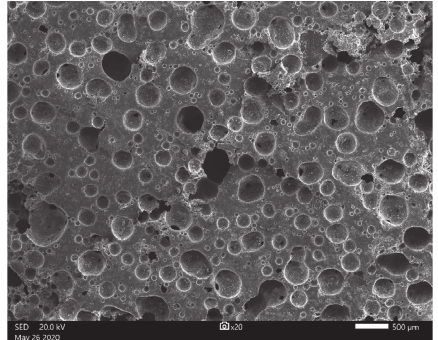
Figure 11: SEM micrograph of the foam structure of specimen b5 (4.5%